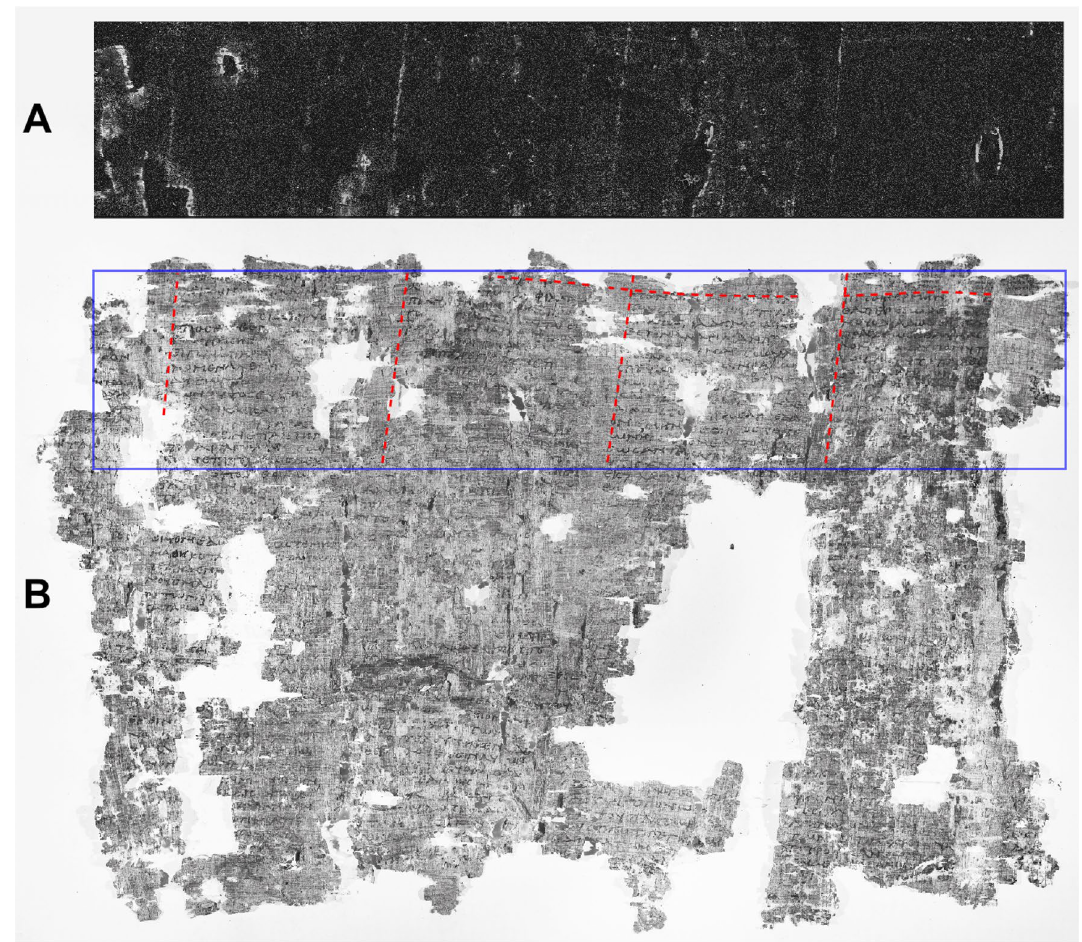
Figure 1. PHerc. 1021, ‘cornice’ 1. Pb distribution map obtained by MA-XRF scanning. By permission of the Ministero della Cultura (photo credit: Biblioteca Nazionale “Vittorio Emanuele III,”